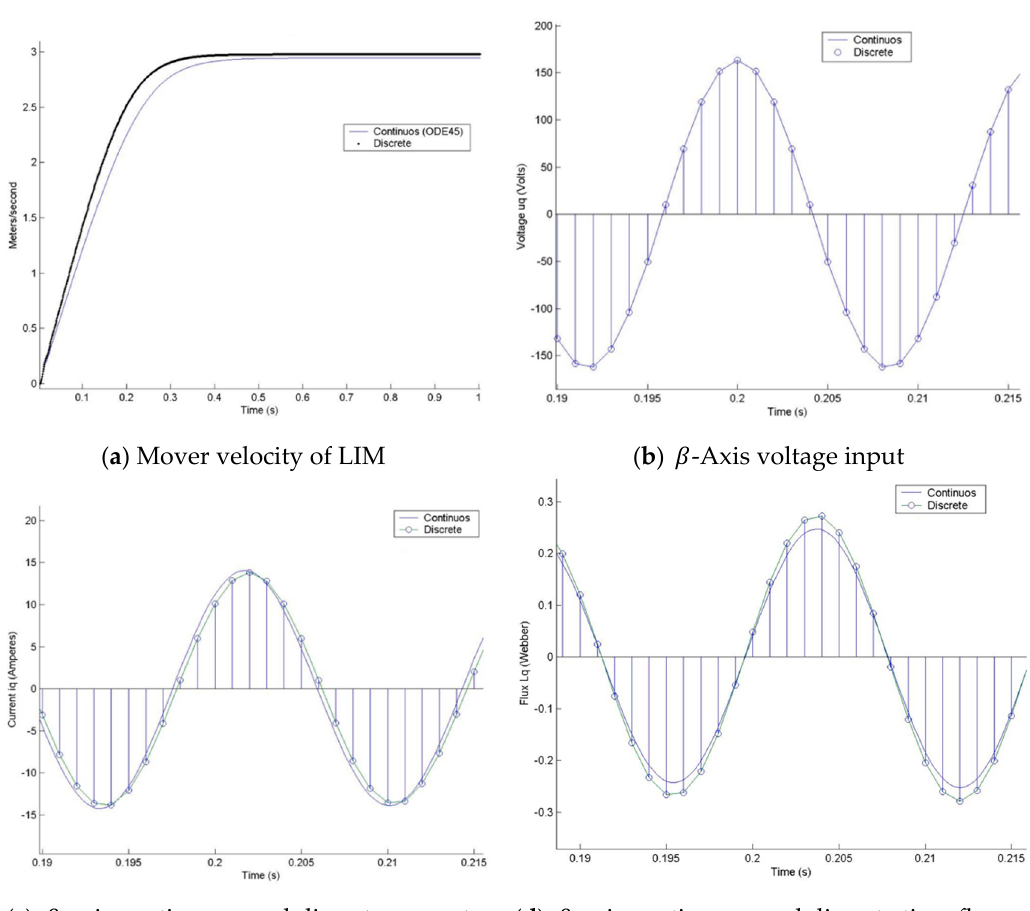
Figure 3. Mover velocity, voltage, currents, and fluxes resulting from the model simulation using the ODE45 function of Matlab in the continuous and discrete time models of LIM.